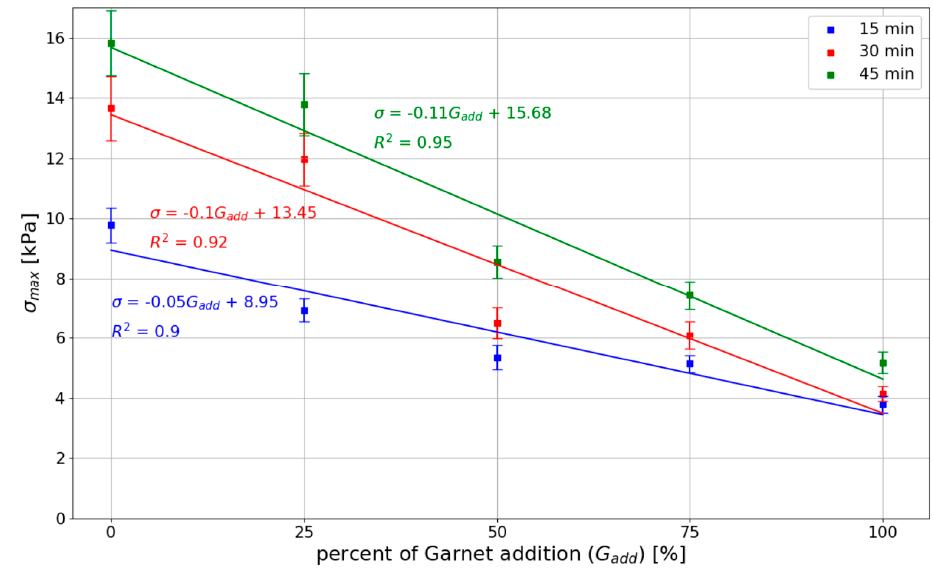
Figure 14. Relationship between garnet content and maximum green strength.